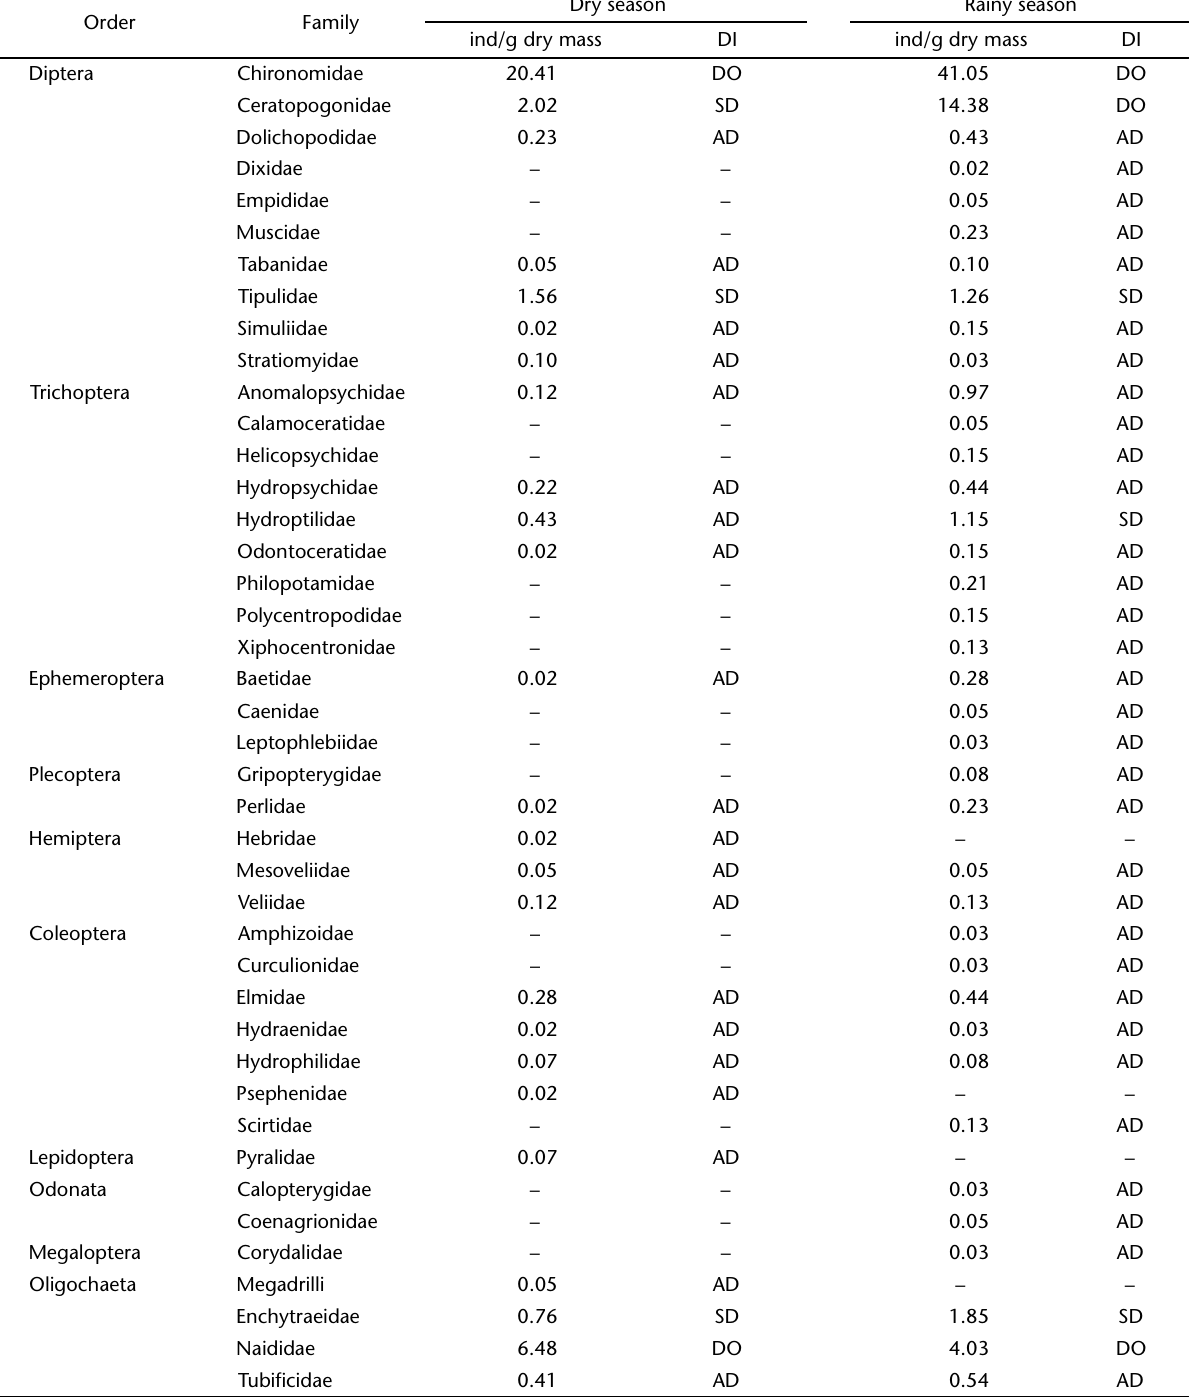
Table II. Mean density of individuals (ind/g dry mass) and dominance index (DI) of the macroinvertebrate fauna in stream bryophytes in the Poço D’Anta Biological Reserve, during the dry and the rainy season. Dominant (DI > 10) = DO, subdominant (1 < DI < 10) = SD and adominant (DI < 1) =